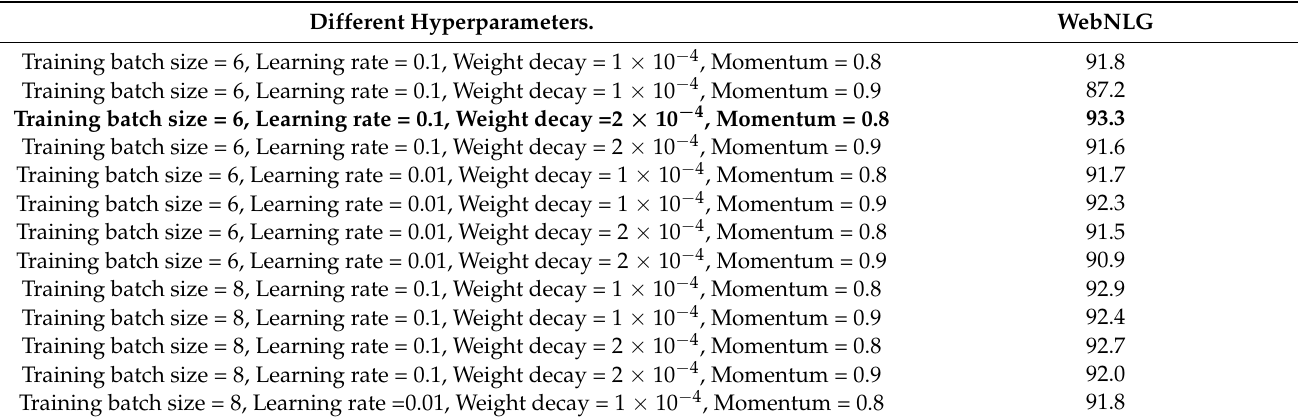
Table 7. F1 (%) of different hyperparameter